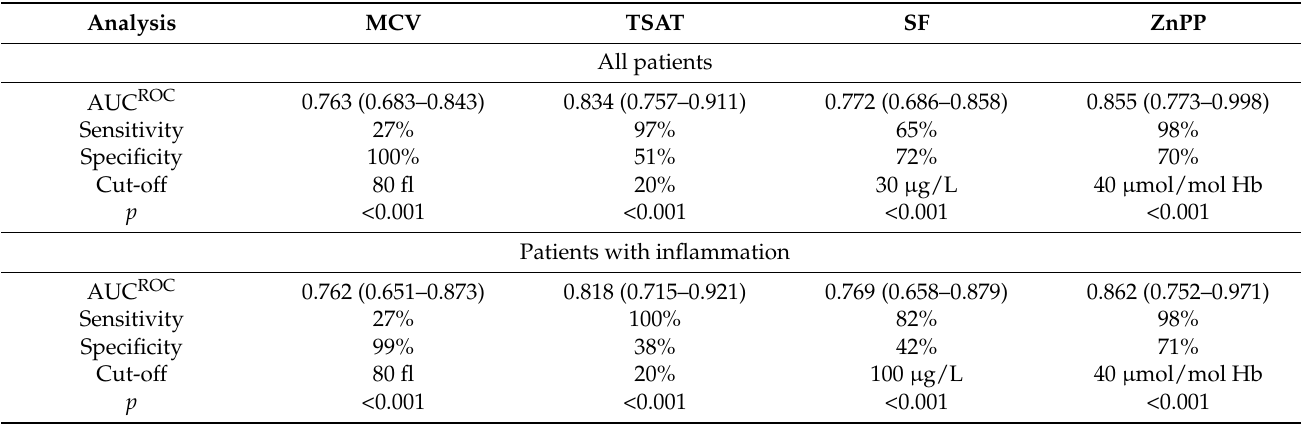
Table 3. Analytical performance of iron status parameters to detect patients with IRE depending on the probability of co-presence of